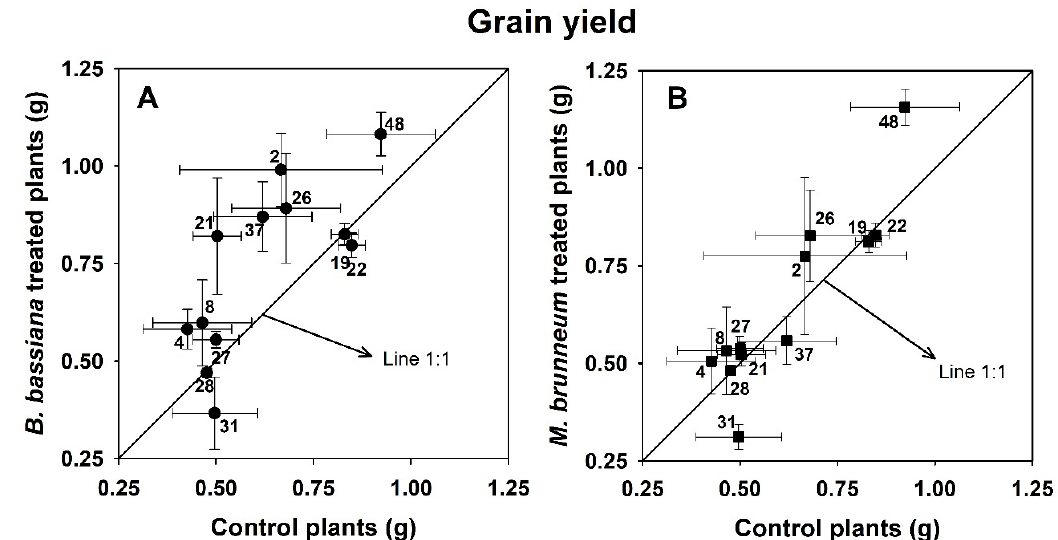
Figure 1. Grain yield (mean ± SE, n = 6) of durum wheat plants inoculated with B. bassiana ( A ) and M. brunneum ( B ) ( y- axis) against grain yield of the Control plants ( x- axis) on the different soils. The numbers by the symbols are the soil codes. The 1:1 line represents the mean value of the Control treatment for each soil, the horizontal error bars of the spots correspond to the standard errors for non-inoculated plants and the vertical bars to those for the fungus-treated plants. Table 2. Paired t- test for biomass variables (mean ± SE, n = 72) of inoculated versus non-inoculated plants at harvest (102 DAS). Significant p -values ( p < 0.05) are in boldface. Treatments Grain Yield Straw Harvest Index ‡ Grains Tillers g plant ‒ 1